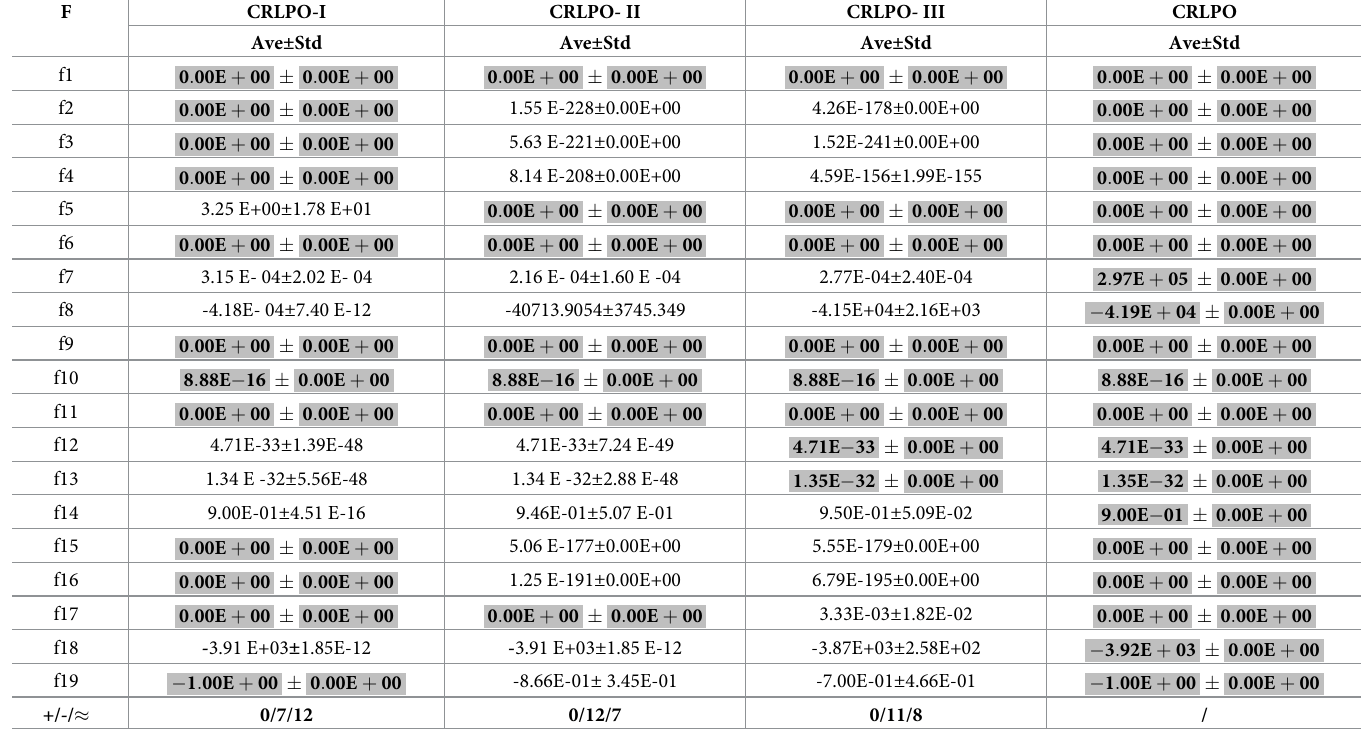
Table 9. Experimental results of effectiveness evaluation of two components of CRLPO on 19 test functions from Table 1 with 100 dimensions.